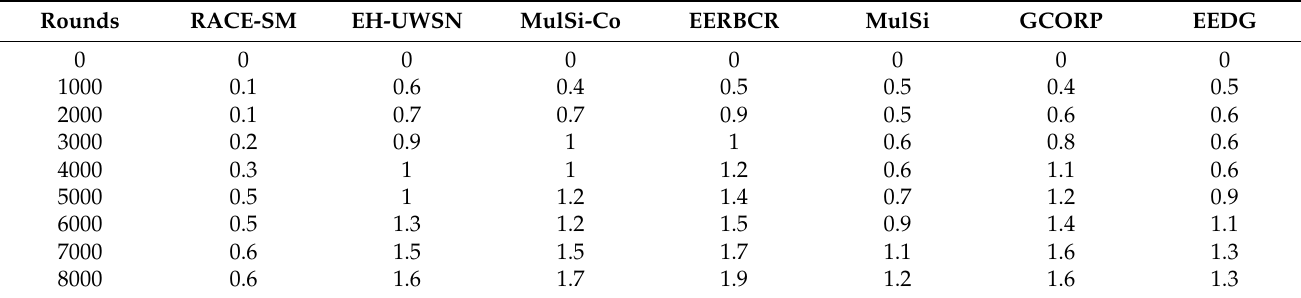
Table 3. The end-to-end delay of all evaluated routing protocols.